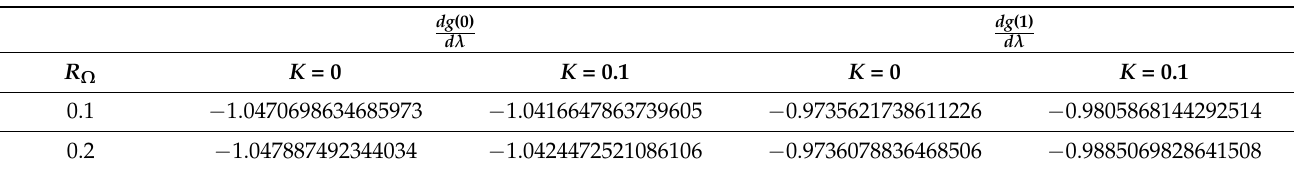
Table 6. Numerical computations of Torque at a fix circular and upper circular plates by DTM-Pad é [ 5 × 5 ] for multiple values of Rotational Reynolds Number R Ω